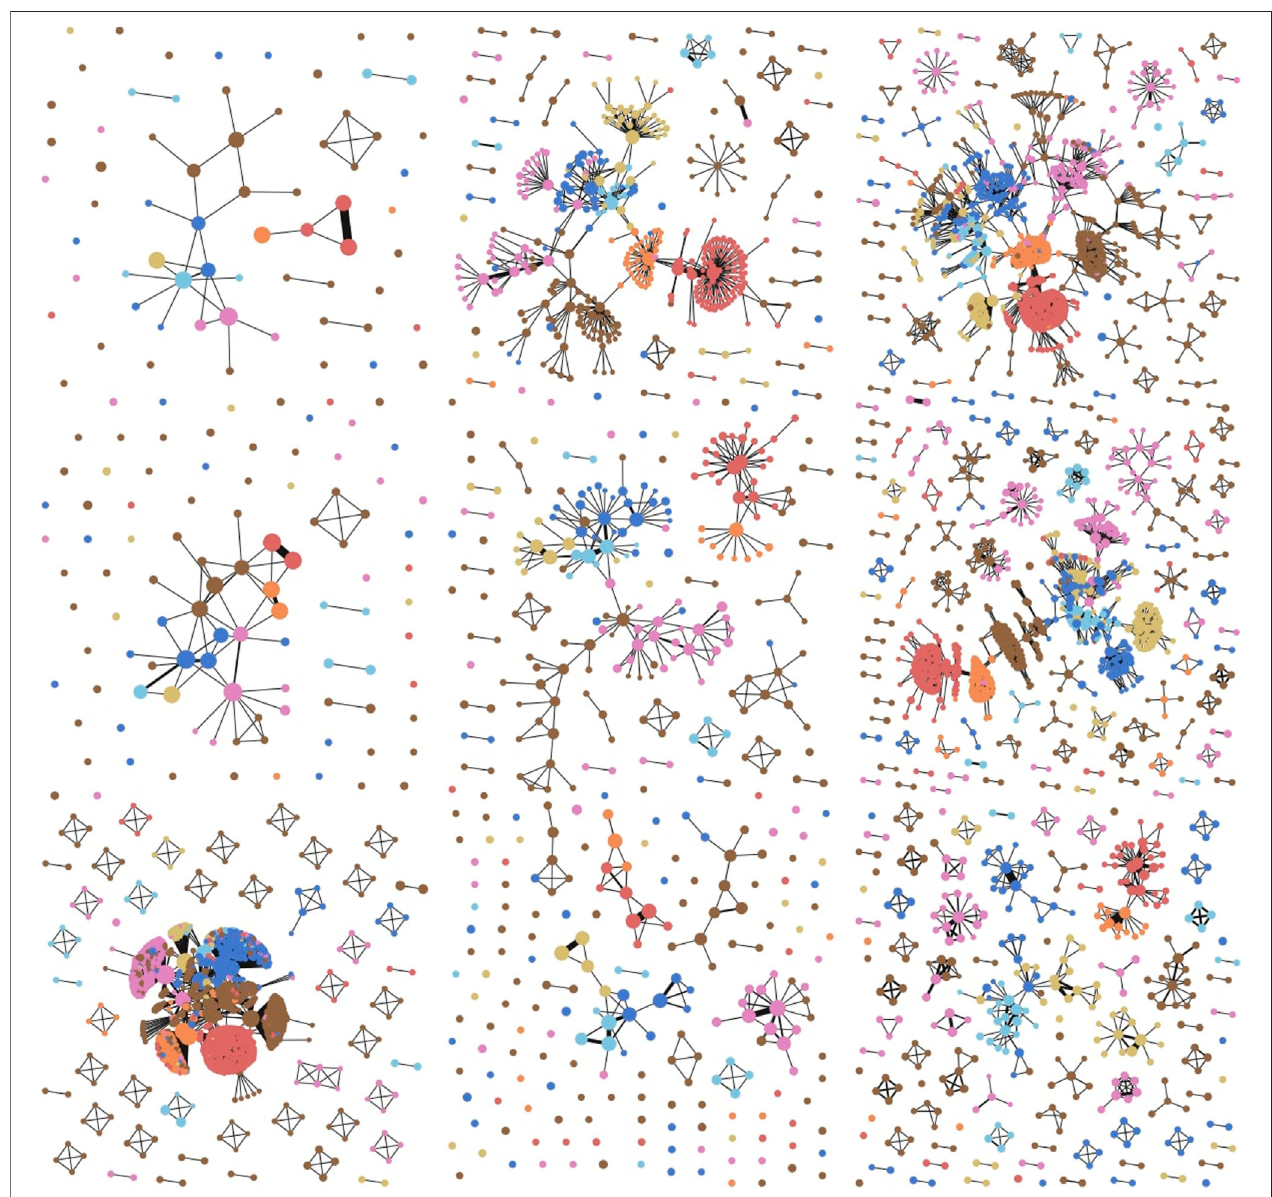
FIGURE7| HierarchicalvisualisationsoftheCoracitationnetworkusingvariousnumberofcovercellsanddegreesofoverlap.Rows (top – bottom) haveadifferent overlap ( g ) between intervals: g (cid:1) 0 . 1, g (cid:1) 0 . 25, g (cid:1) 0 . 35; columns (left – right): n (cid:1) 16, n (cid:1) 64, n (cid:1) 256.